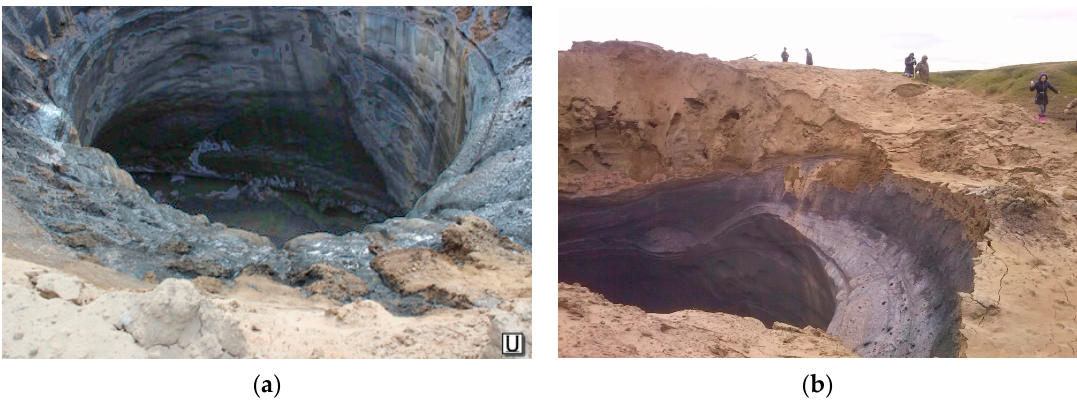
Figure 7. AntGEC inner structure: ( a ) the diameter of the cylindrical portion of the crater was 10–13 m in the summer of 2014 and vertical walls height was estimated as 5–6 m [26]; ( b ) sandy deposits with different thicknesses cover tabular ground ice in the upper part of the crater walls. Photo by courtesy of Kh. S. Okotetto.